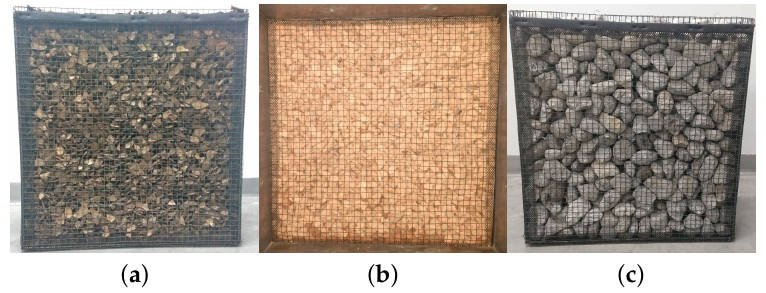
Figure 1. Photographies of the pad built with the alternative materials. ( a ) Coconut shells pad. ( b ) Burnt clay hollow brick pad. ( c ) Pumice stone